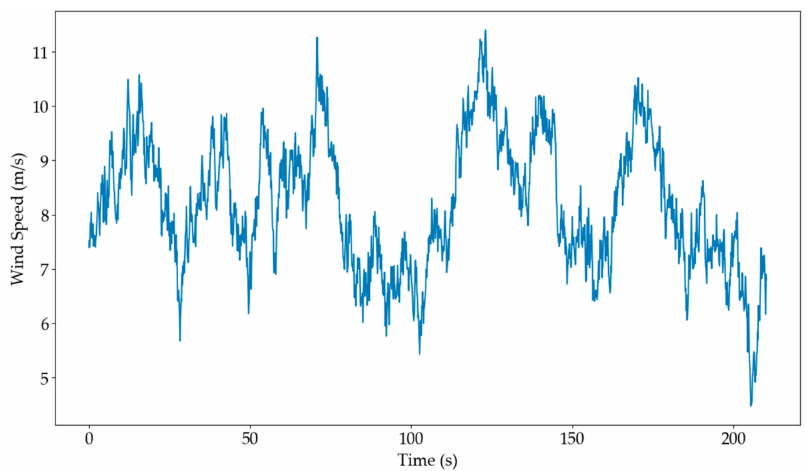
Figure 1. The variable wind speed of test data.